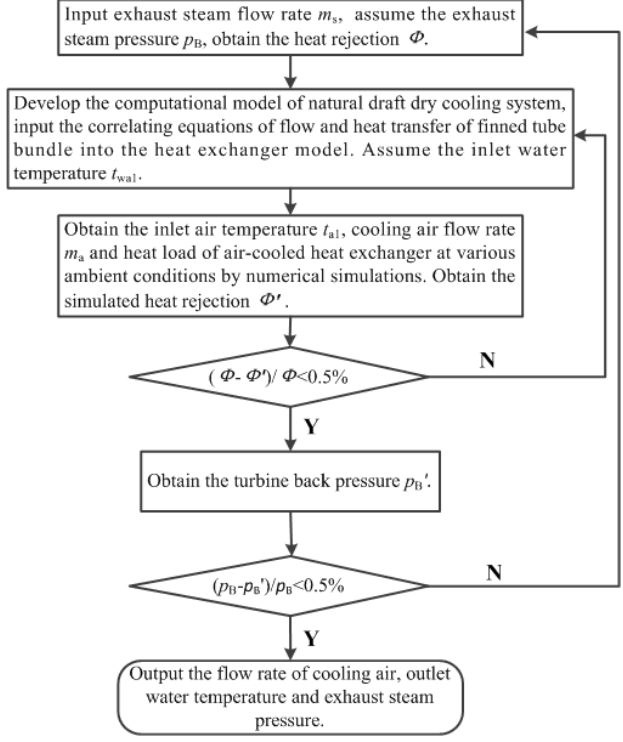
Figure 6. Numerical heat transfer process of cold end system.